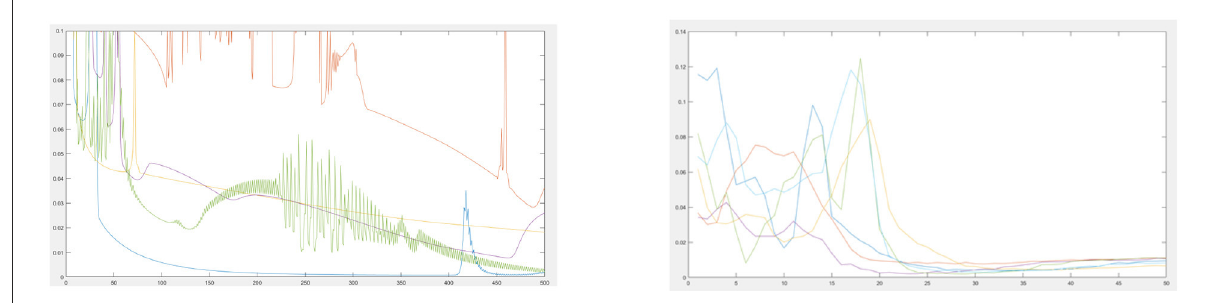
FIGURE1 Error by epoch when training without (left) and with (right) simulated annealing.